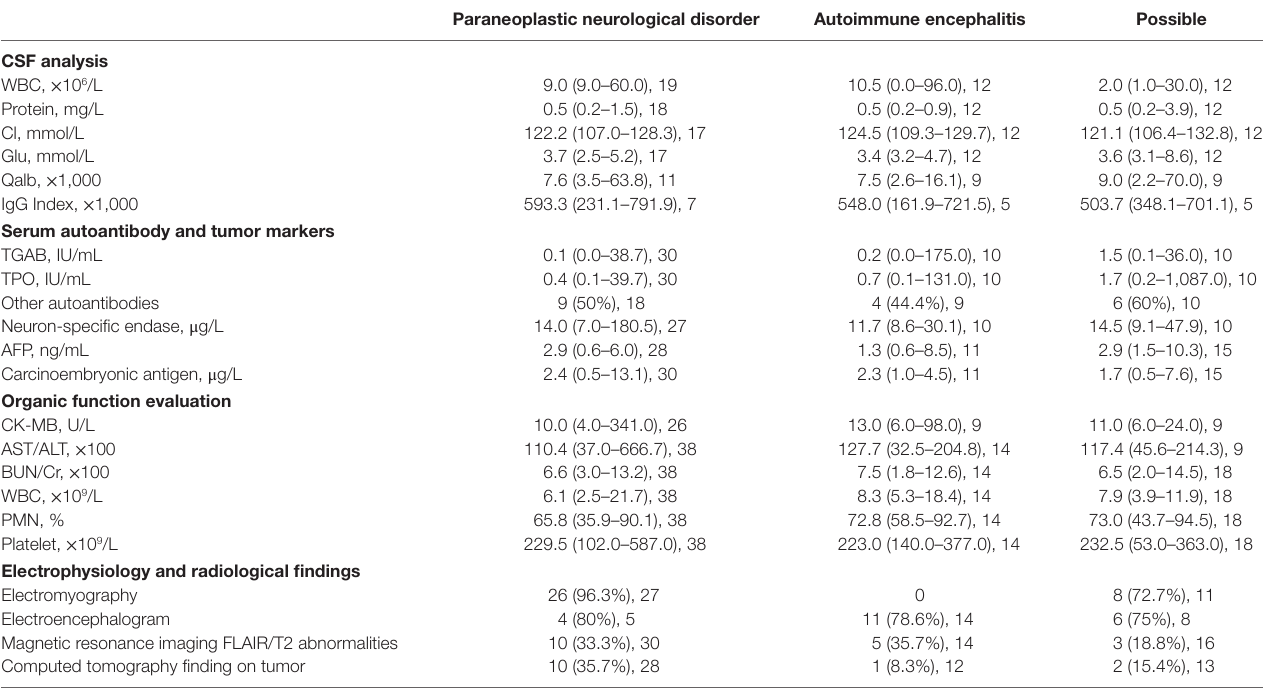
Table 3 | Cerebrospinal fluid (CSF), other test results, electrophysiology, and radiological findings. Paraneoplastic neurological